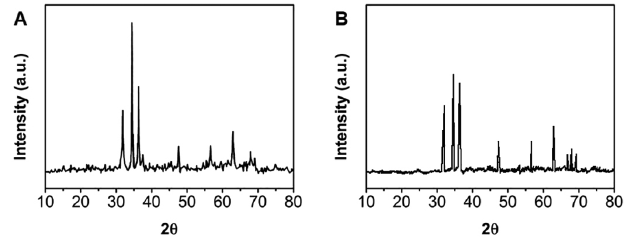
FIGURE 2 - X-ray diffraction pattern of (A) biosynthesized ZnO nanoparticles and (B) chemically synthesized ZnO.